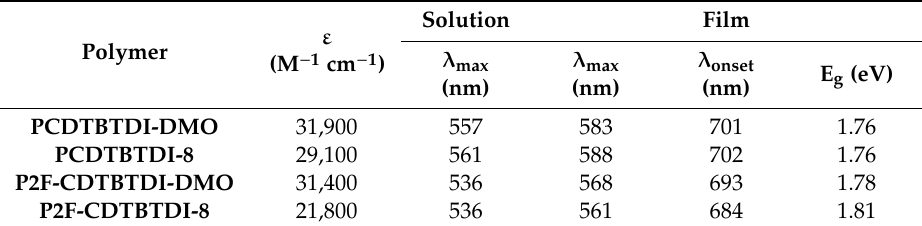
Table 2. Uv-vis data and optical band gaps of the polymers.